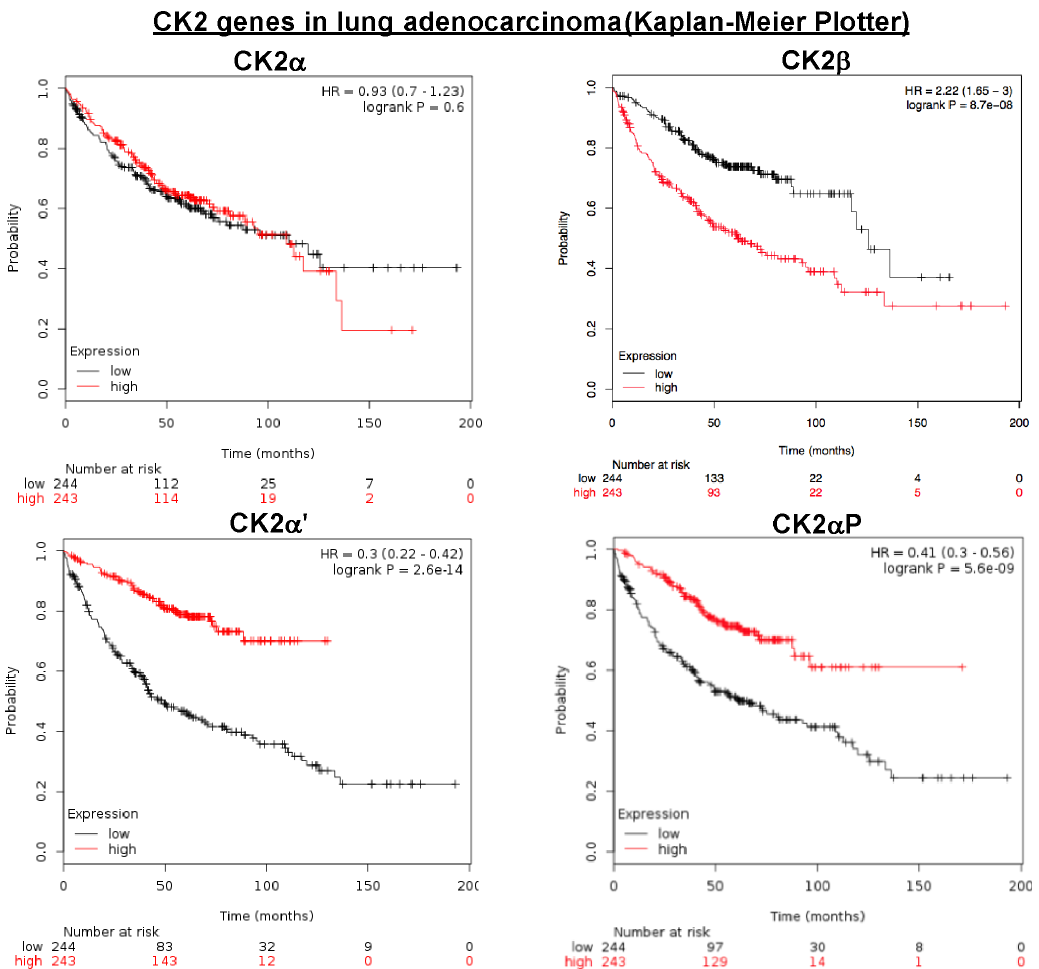
Fig. 3. CK2 genes in lung adenocarcinoma (Kaplan-Meier Plotter). Kaplan-Meier plots showing overall survival in lung adenocarcinoma. In red: patients with expression above the median and in black, patients with expressions below the median. CK2 a , p 5 0.6008; CK2 a P, p 5 5.6 10 2 9 , CK2 a ’, p 5 2.6 10 2 14 ; CK2 b , p 5 8.7 10 2 8